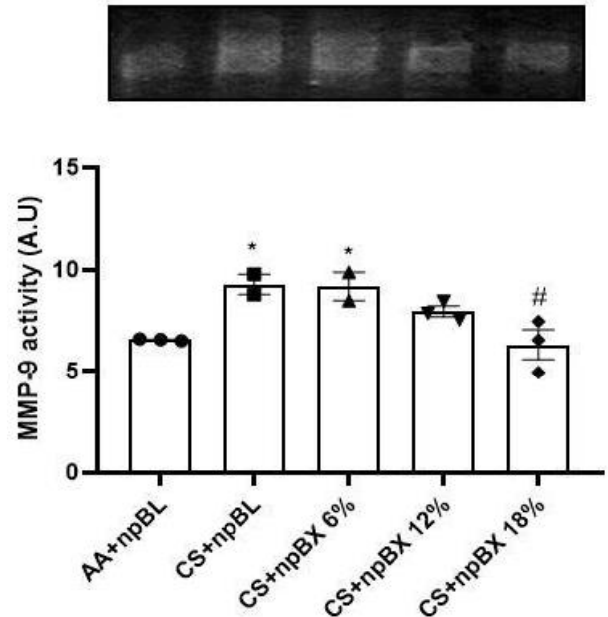
Figure 9. Bixin-loaded nanoparticles inhibit CS-induced MMP-9 activity in lung homogenates. MMP-9 enzyme activity determined by SDS-PAGE gel zymography with 1.5 mg/mL gelatin. * p < 0.05 compared to AA + npBL; # p < 0.05 compared to CS + npBL.